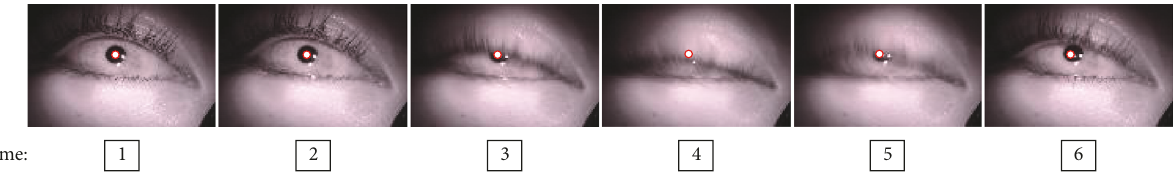
Figure 5: Annotation of medium and closed eye